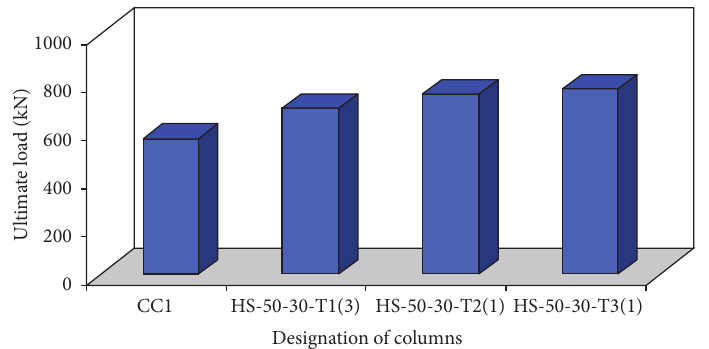
Figure 19: Ultimate load for columns HS-50-30—comparison.